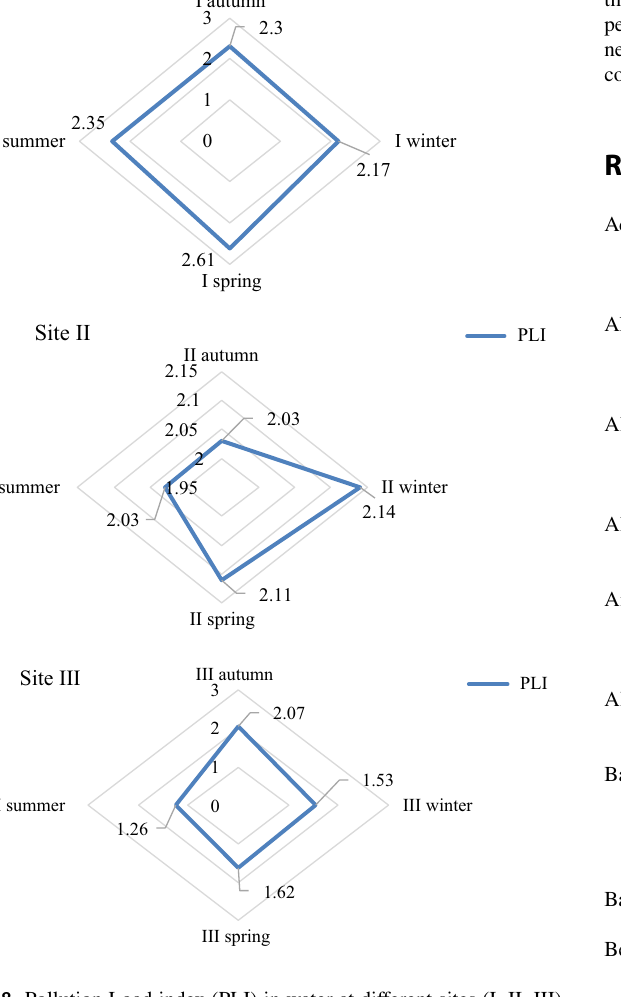
Fig. 8 Pollution Load index (PLI) in water at different sites (I, II,